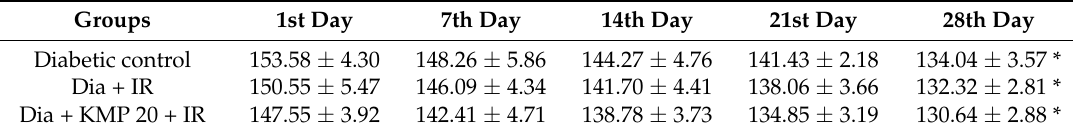
Table 1. Effect of kaempferol on body weight changes. Data are expressed as the mean ± standard error of mean (S.E.M).; n = 6 in each group. * p < 0.05 vs. baseline value in respective groups. Dia + IR: diabetes